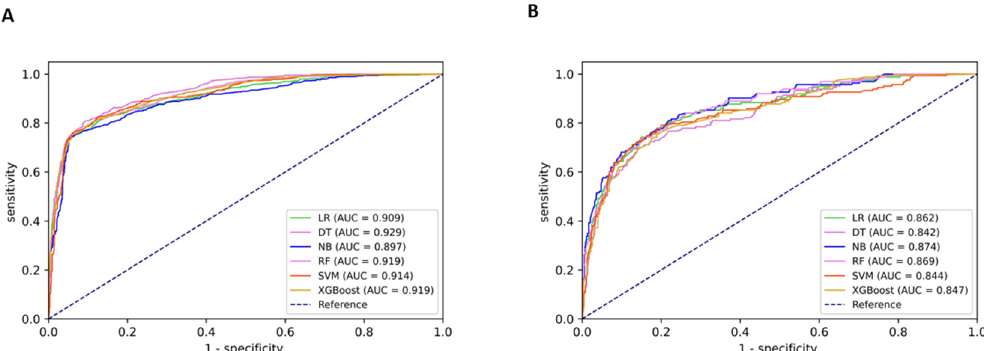
Figure 2. Performance of different models for detecting HSIL+. Displayed are receiver operating characteristic (ROC) curves and the area under the curves (AUC) of different models in detecting high-grade squamous intraepithelial lesions or worse (HSIL+). Different colors represent different models. LR, logistic regression; SVM, support vector machine; DT, decision tree; NB, naïve bayes; RF, random forest; XGBoost, extreme gradient boosting. ( A ) internal validation; ( B ) external validation. Table 3. Ranking of variable importance.